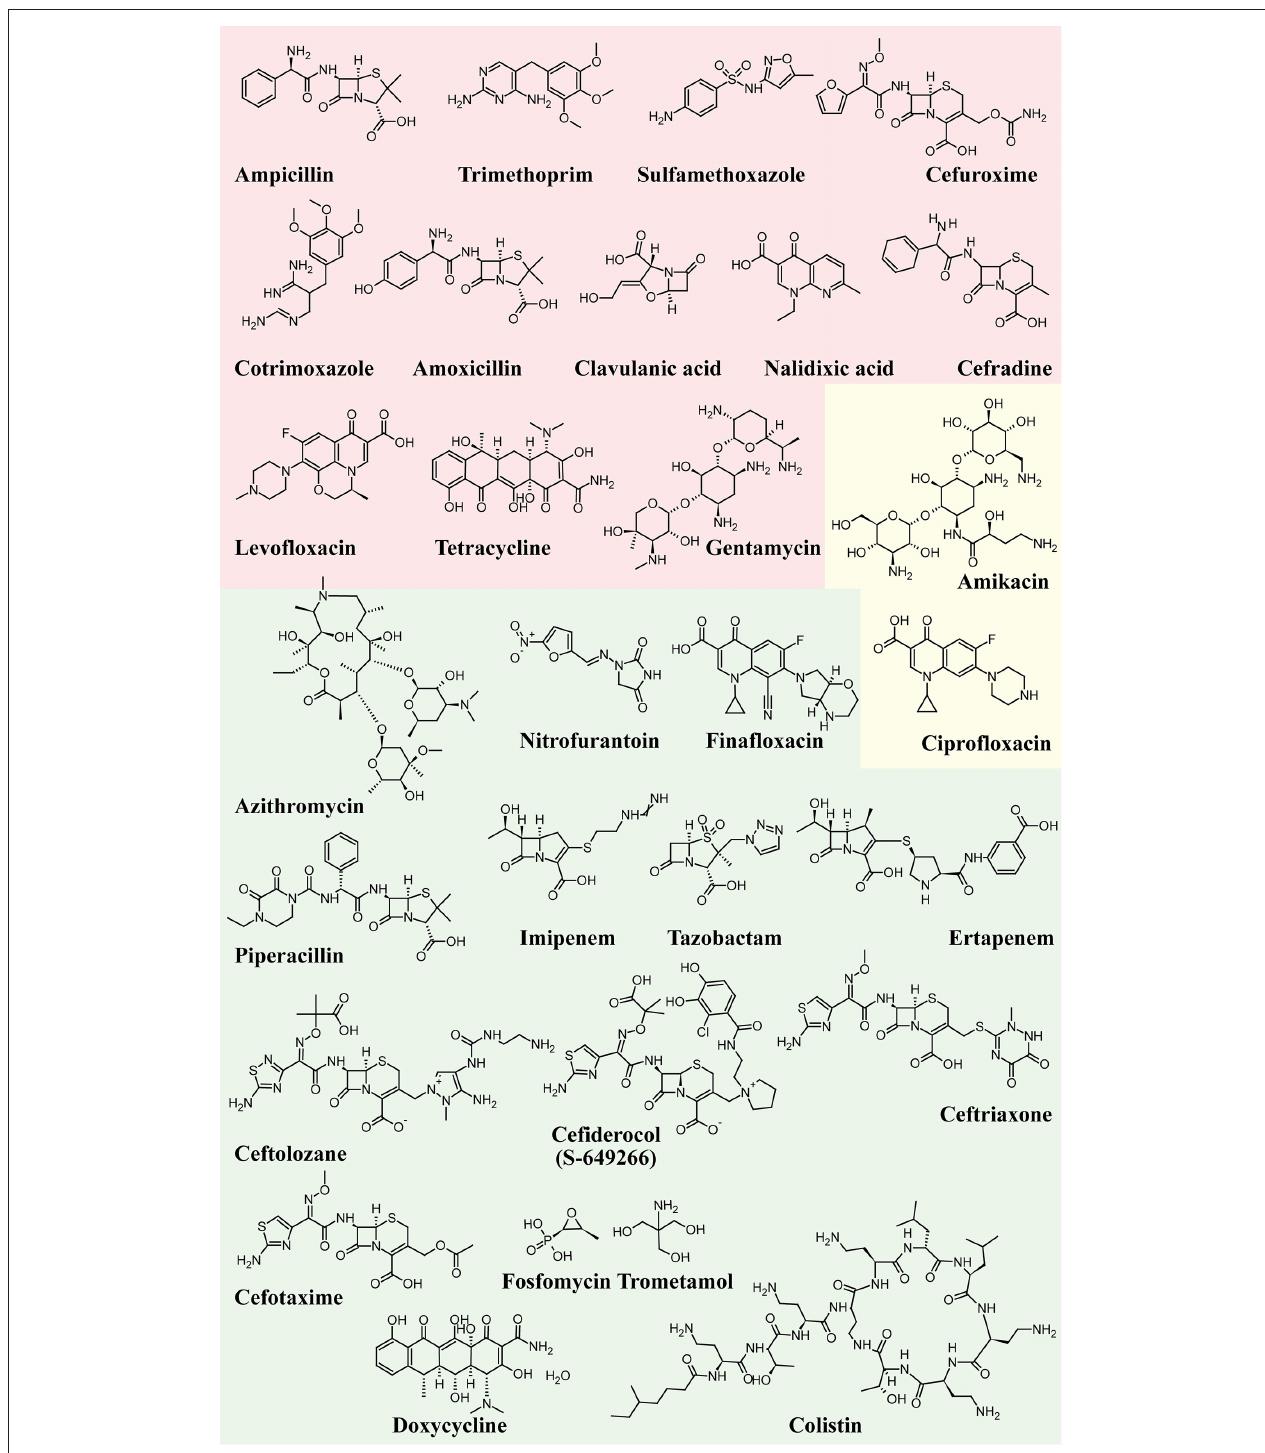
FIGURE 4 | Structure formulae of some UPEC resistant and susceptible antibiotics. UPEC resistance is shown with a red background, susceptibility with a green background, whereas the yellow background shows antibiotics that already show resistance in some UPEC strains.